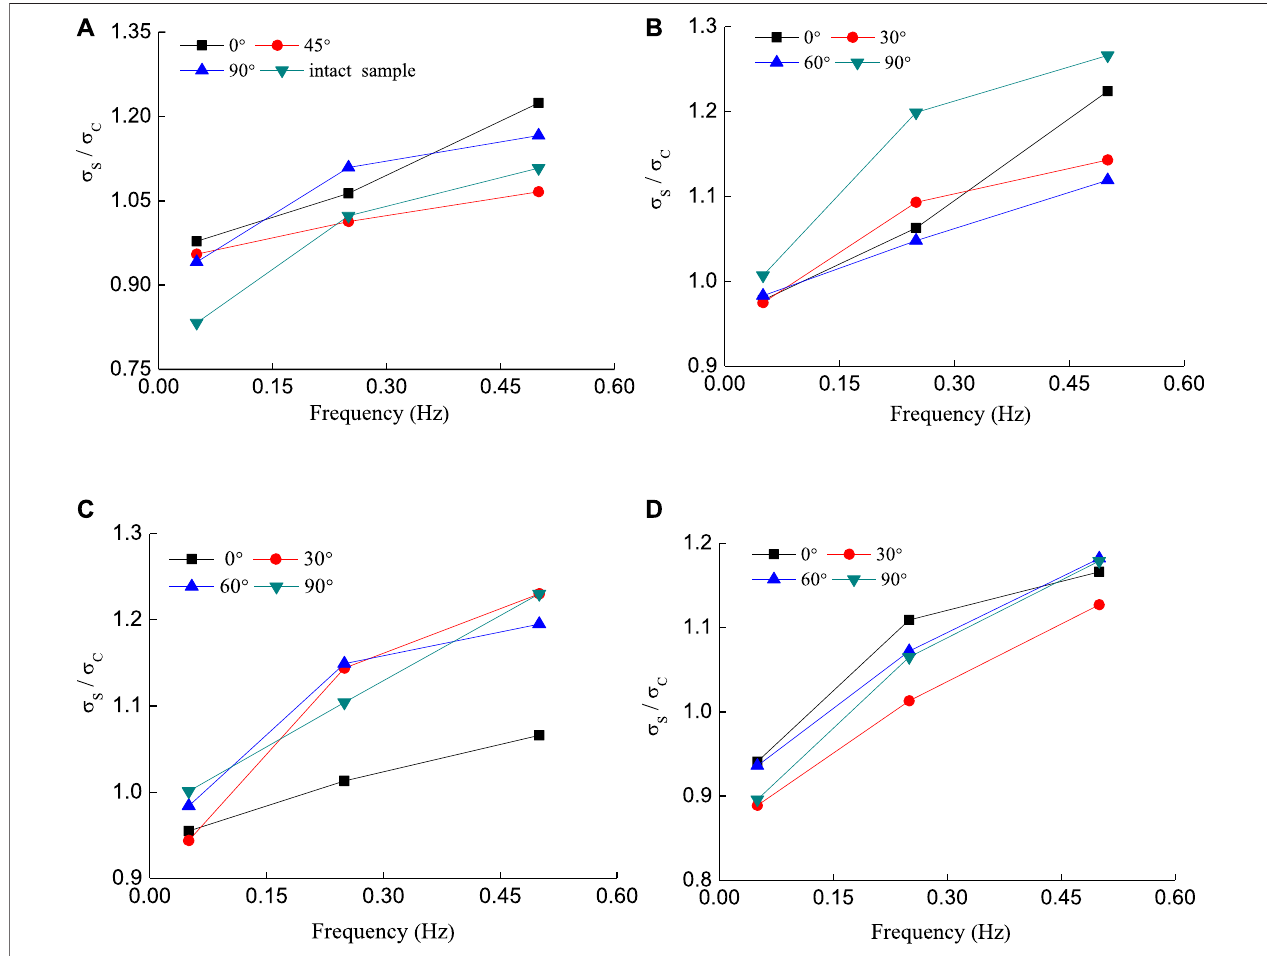
FIGURE 11 | The relationship between the ratio of dynamic strength to static strength and the frequency, (A) single crack samples with different inclination, (B) T-shapedcracksamplescontainingaprimarycrackinclination angleof0 ° , (C) T-shaped cracksamplescontainingaprimarycrackinclinationangleof45 ° , (D) T-shaped crack samples containing a primary crack inclination angle of 90 ° .